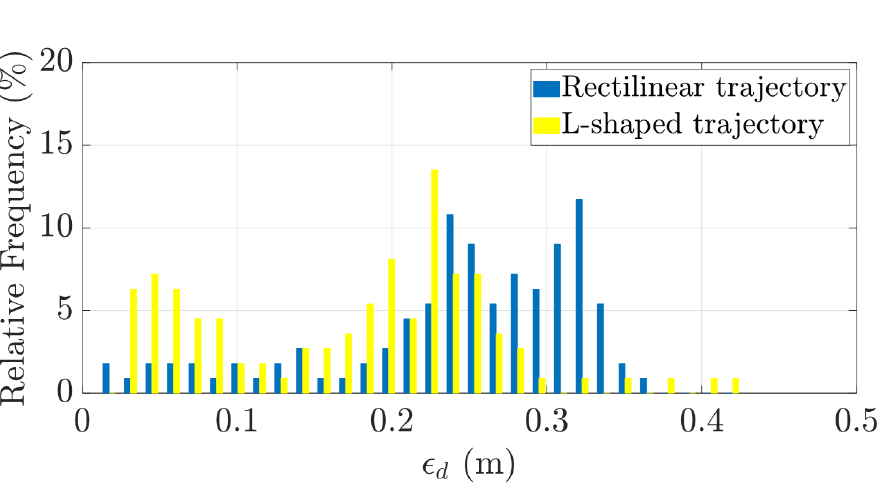
Figure 11. Histograms of the 2D localization error. Blue bars refer to rectilinear trajectories (726 sample points), whereas yellow bars to L-shaped trajectories (668 sample points).